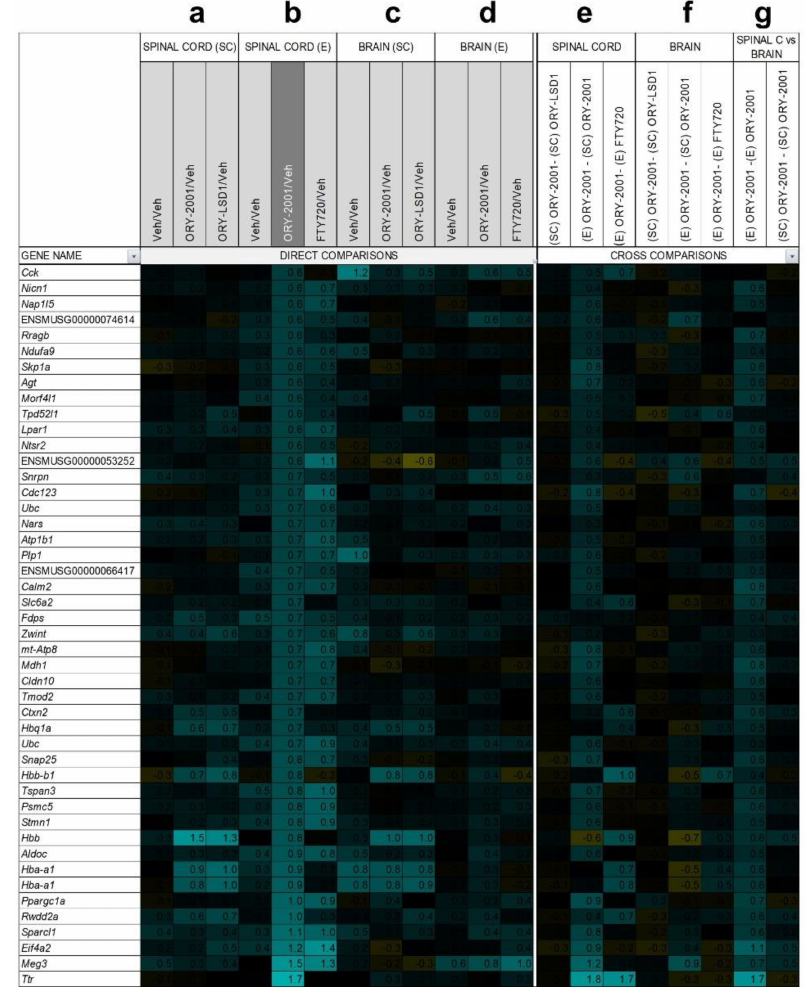
Figure 8. Genes up-regulated by ORY-2001. Microarray survey of gene expression changes in the spinal cord ( a ) and in the brain ( c ) in the sub-chronic phase (SC) 3 days after the last dose. Animals were treated with vehicle (Veh), ORY-2001 (0.5 mg/kg) or ORY-LSD1 (180 µ g/kg). Microarray survey of gene expression changes in spinal cord ( b ) and in the brain ( d ) in the effector phase ( e ) 24 h after treatment. Animals were treated with vehicle, ORY-2001 (0.5 mg/kg) or FTY720 (1.0 mg/kg). Cross comparison of the effect of the different treatments and disease phases in the spinal cord ( e ) and in the brain ( f ). ( g ) Cross comparison of the effects of ORY-2001 in spinal cord and brain, in both phases. The number of samples for each survey, representation of changes in gene expression, and selected genes were performed as described in Figure